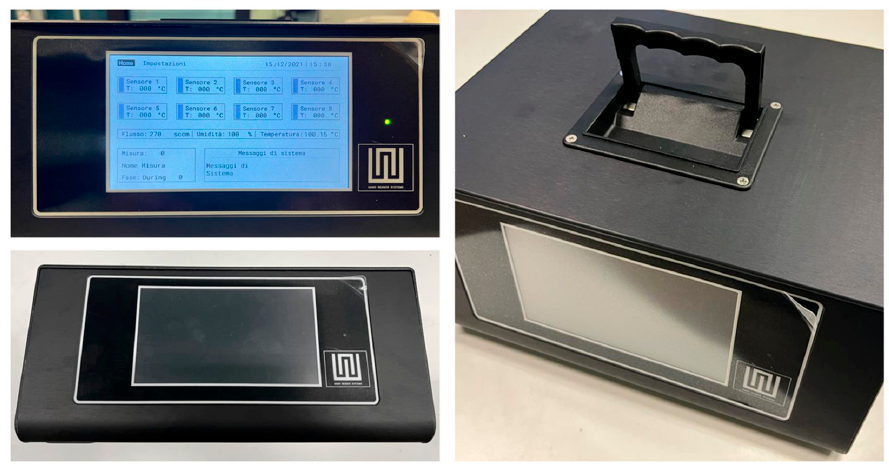
Figure 1. Flow sheet wine vinegar production.